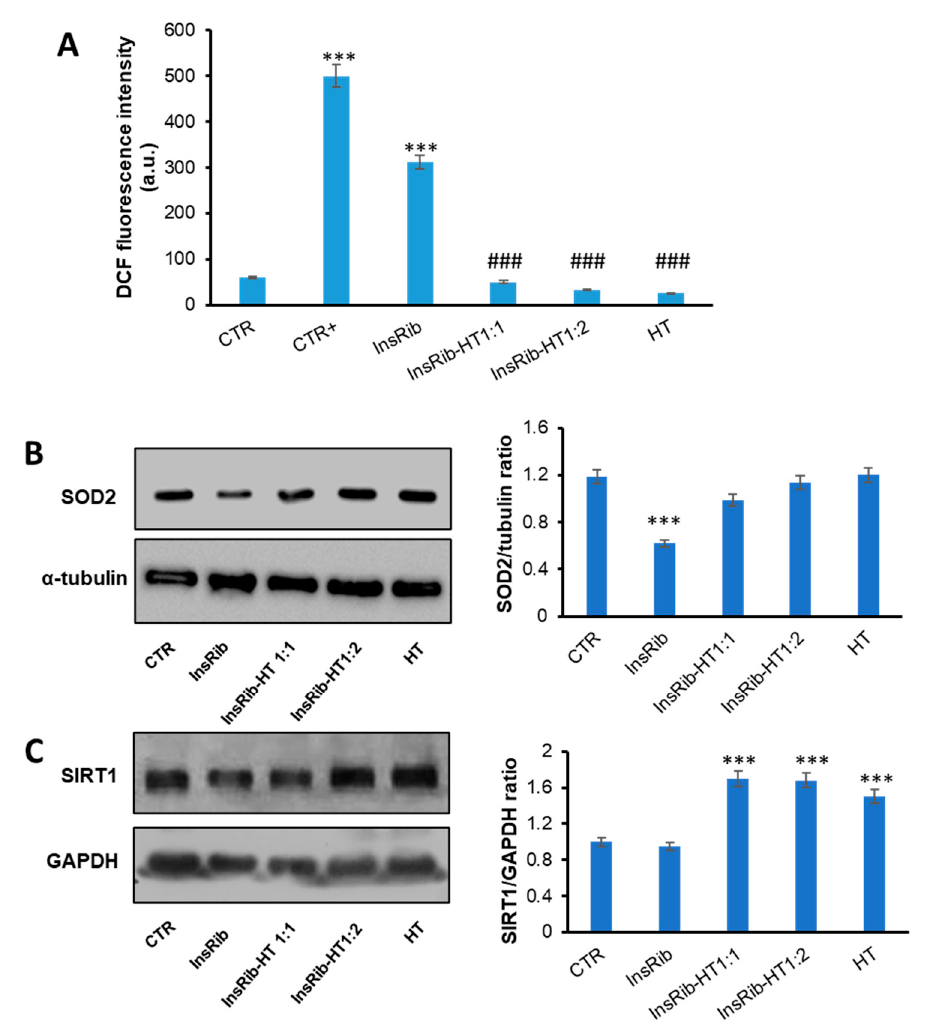
Figure 7. Role of HT in AGE-induced oxidative stress. SHSY5Y cells were co-incubated with glycated insulin (InsRib) and HT (1:0, 1:1, 1:2 molar ratio) and the effect of HT was evaluated in ROS production by DCFH-DA assay ( A ), SOD2 expression ( B ) and IRT1 expression ( C ) by western-blot analysis. CTR: cells treated with non-glycated insulin; HT: cells treated with the higher working concentration of HT; CTR+: cells treated with 1.0 mM H 2 O 2 . Data are expressed as average ± S.D from five independent experiments carried out in triplicate. Other experimental details are described in the Methods section. *** p < 0.001 versus CTR, ### p < 0.001 versus InsRib.